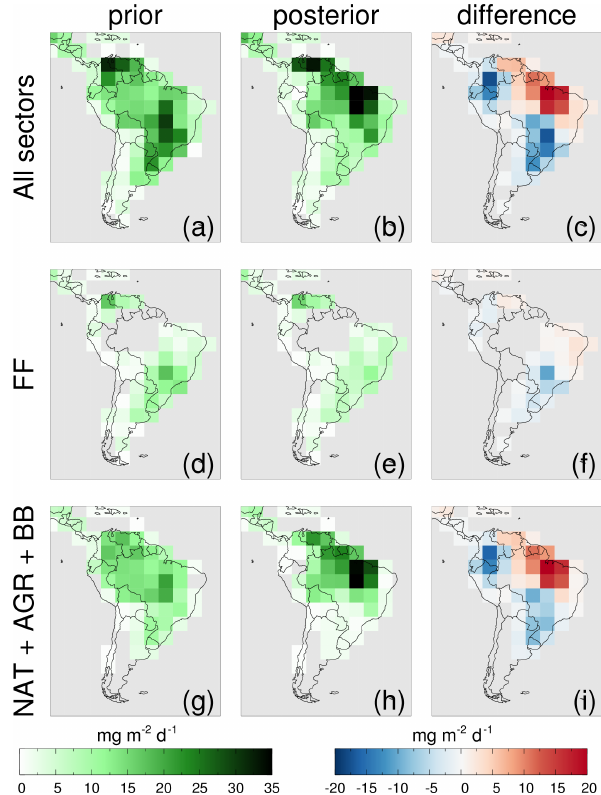
Figure 3. Prior, posterior and (prior–posterior) mean gridded to- tal South American CH 4 emissions (mgm − 2 d − 1 ) for the period 2009–2018 (a–c) , and similar but for fossil fuel sources (d–f) and natural/agricultural/biomass burning sources (g–i)